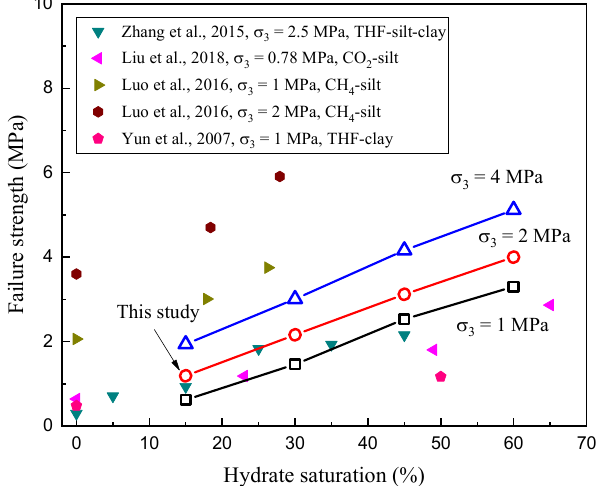
Figure 4. The failure strength of specimen versus hydrate saturation (based on [21–23,27]).